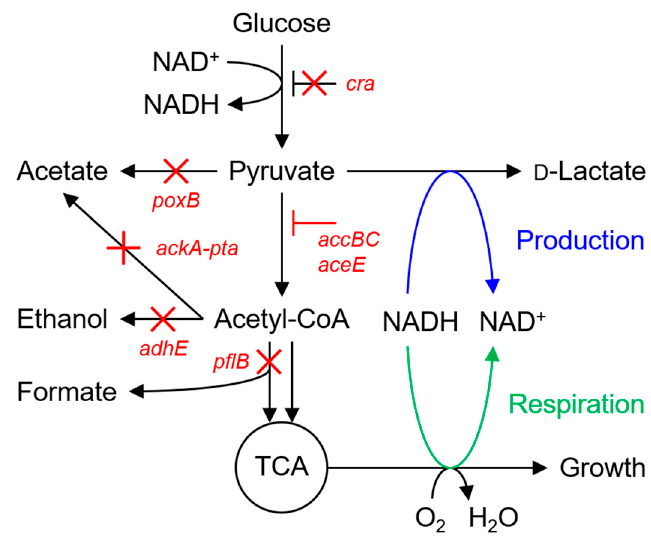
Figure 2. Schematic metabolic pathway of the d -lactate-producing (LAC) strain. The cross-marks denote gene inactivation. d -lactate production (blue) competes with respiration (green) for NADH utilization.